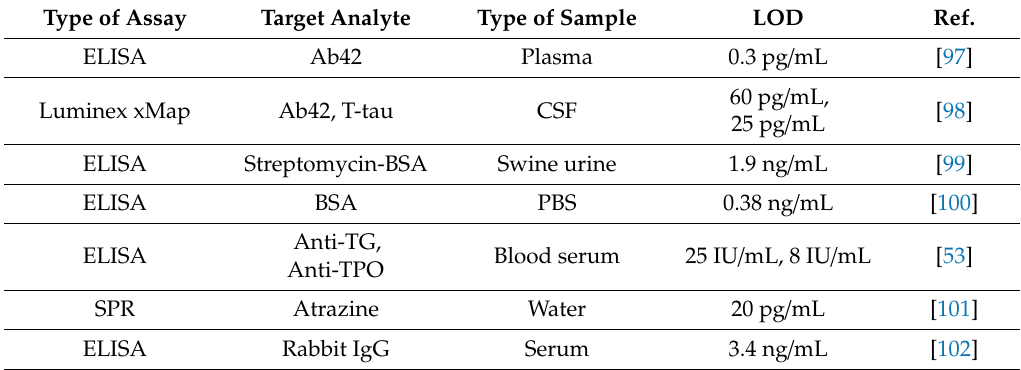
Table 2. Examples of LODs with commercial